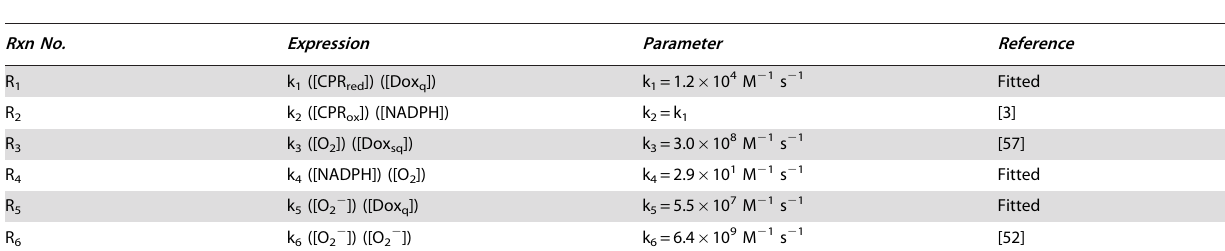
Table 2. Reaction expressions and parameter values for the in vitro Dox model.